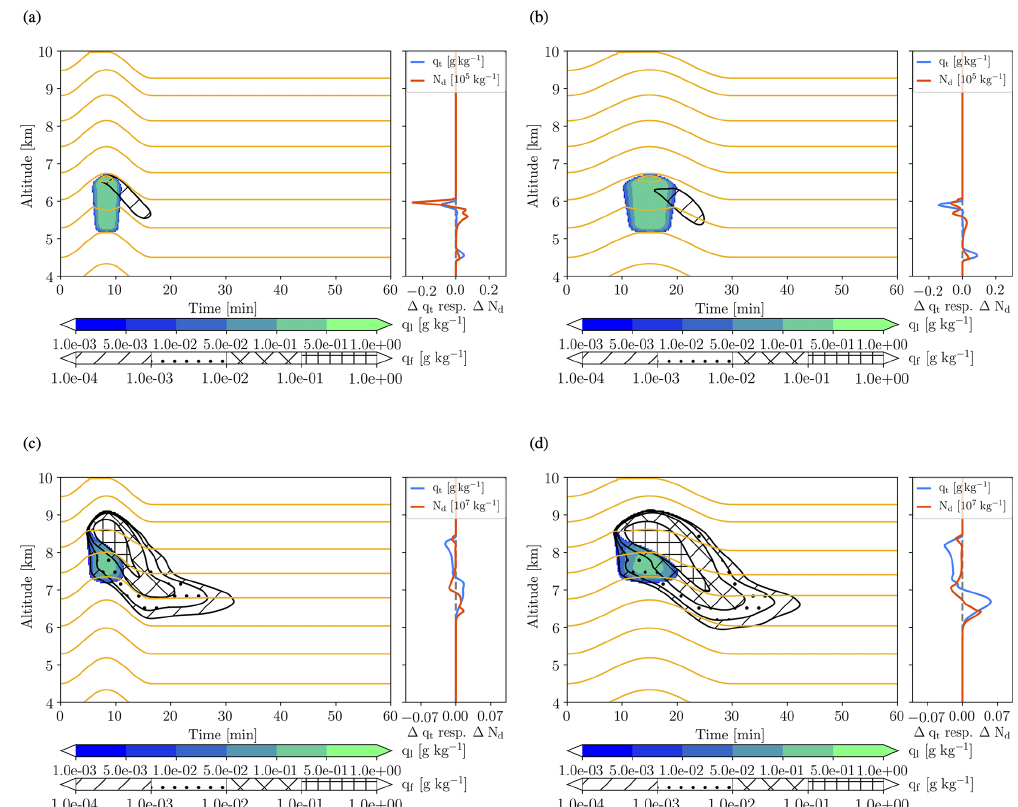
Figure 9. Wave clouds in the KiD model. Simulations of waves with periods of (a, c) 1000s and (b, d) 1800s are shown. The cloud top temperature is − 24 ◦ C in (a) and (b) and − 50 ◦ C in (c) and (d) . The cloud droplet mass mixing ratio is indicated by the colour shading, ice and snow mass mixing ratio by the hatched contours, and the isentropes by orange isolines with a spacing of 2K. The small subpanels show the difference in total water content (light blue line) and the dust number concentration (red line) between the upstream and downstream. Note the different units for the dust number concentration change in (a) and (b) and (c) and (d) ,